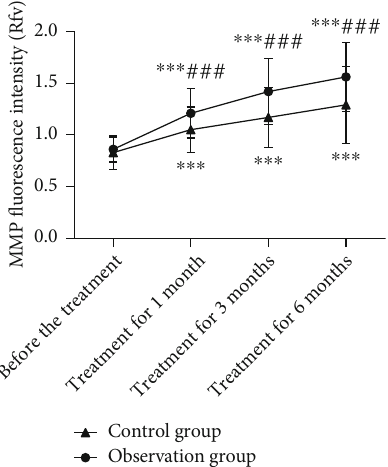
Figure 2: Comparison of mitochondrial membrane potential (MMP) fl uorescence intensity of peripheral blood lymphocytes between the two groups (Rfv). Compared with pretreatment, ∗∗∗ P < 0 : 001 ; compared with the control group, ### P < 0 : 001